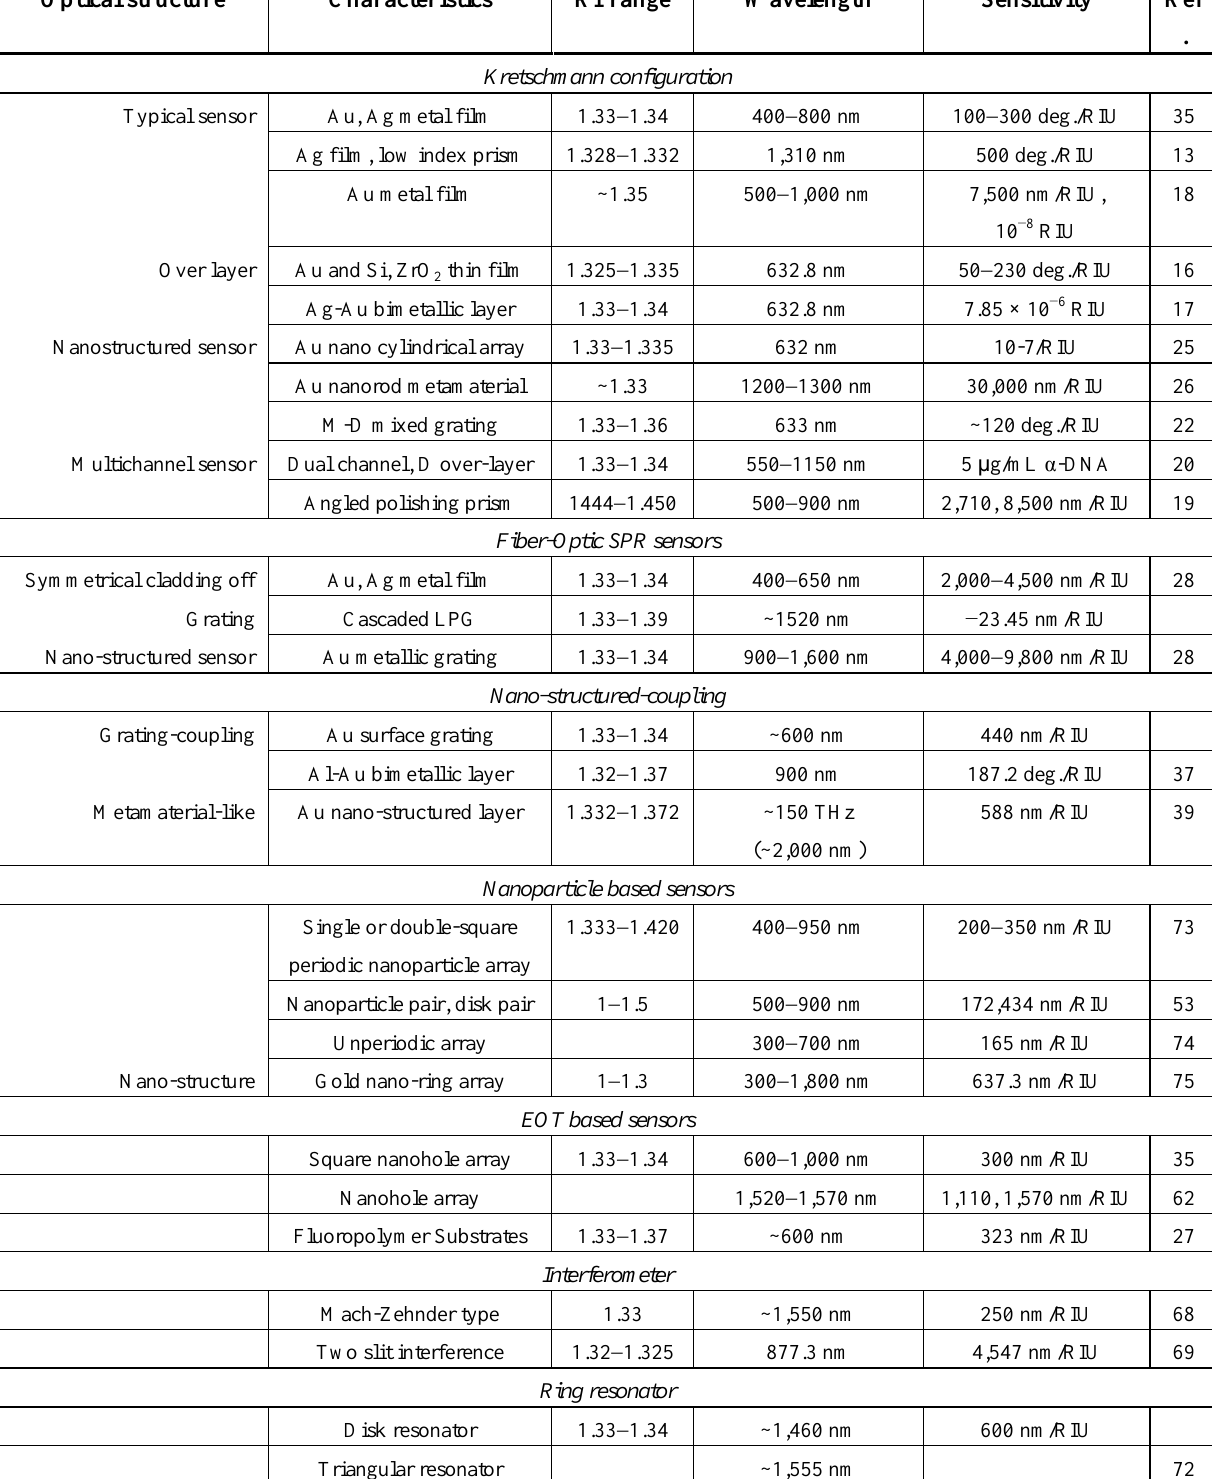
Table 1. Performance of SPR based